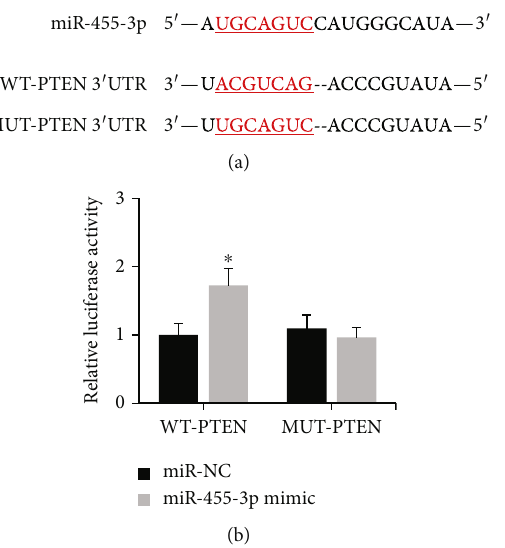
Figure 8: Veri fi cation of target binding between miR-455-3p and PTEN. (a) Target binding position. (b). Detection of target relationship by DLR genes. Note: the comparison with WT-PTEN and miR-NC cotransfection group indicated ∗ P < 0 : 05